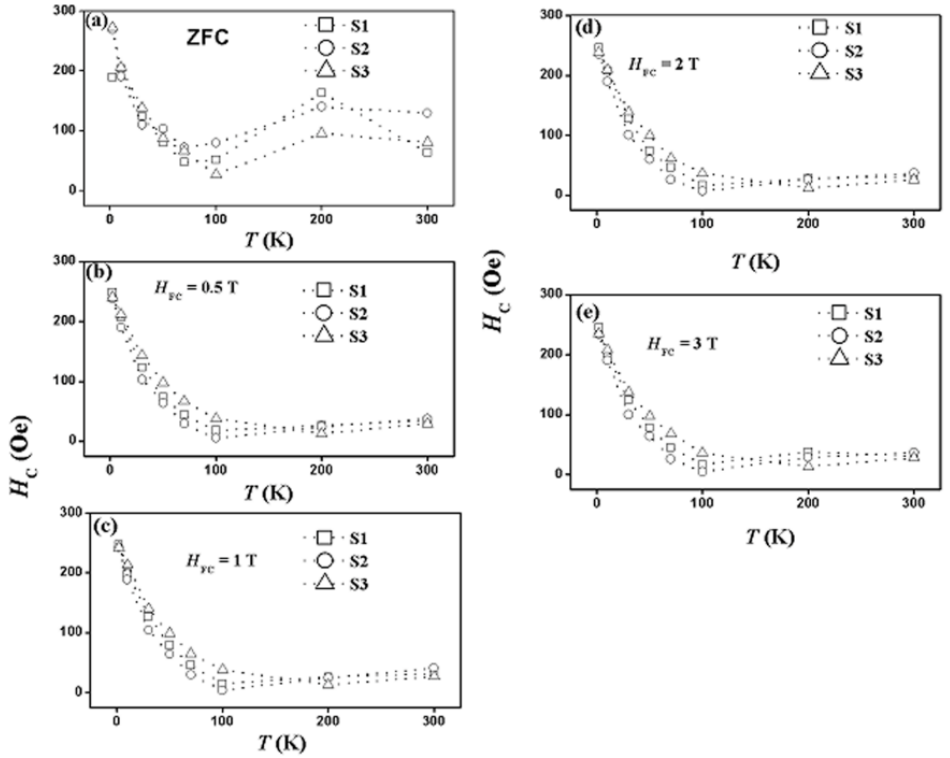
Figure 9. The coercivity as function of temperature for all samples in the zero-field-cooling (ZFC) state and in the field-cooled (FC) state at several field-cooling values.